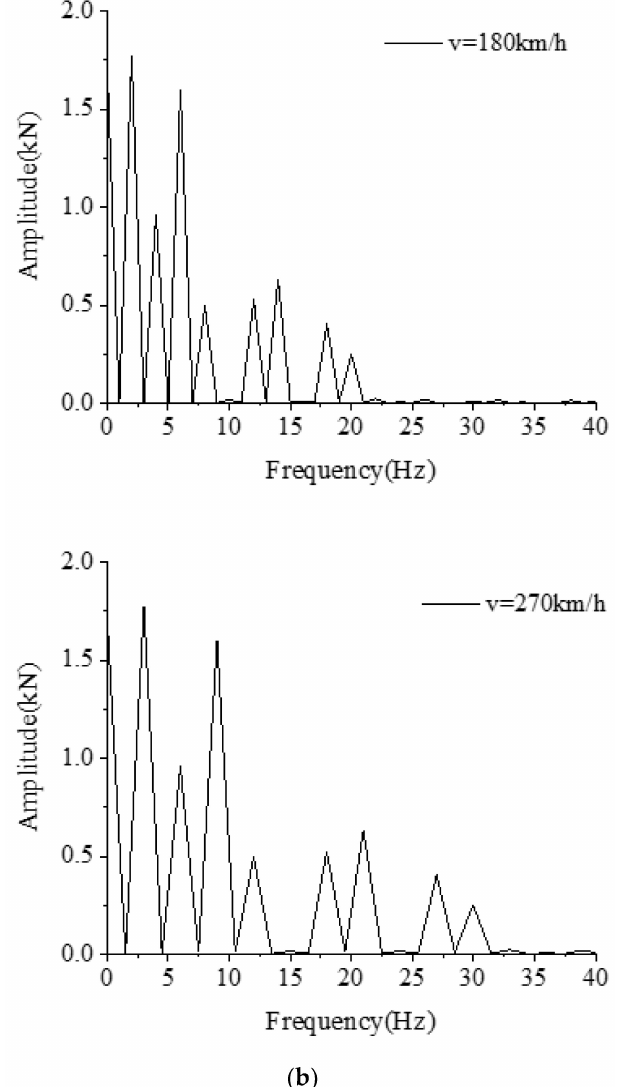
Figure 4. Loading curves at reduced scale for train speed of 180 km/h and 270 km/h in time and frequency domain. ( a ) time domain; ( b ) frequency